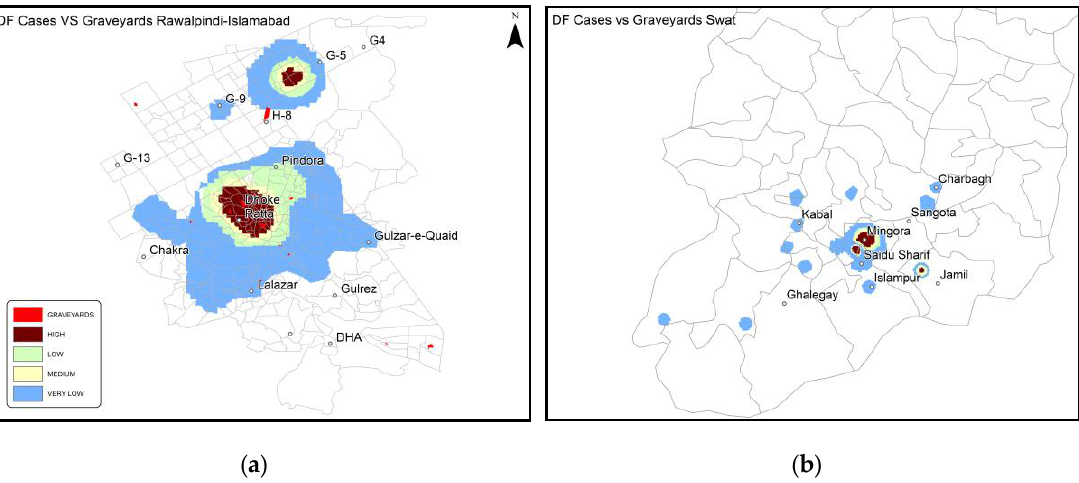
Figure 6. Density Analysis of Dengue cases for five years (2010–2014) and their relationship with graveyards [37]. ( a ) Rawalpindi-Islamabad; ( b ) Swat.